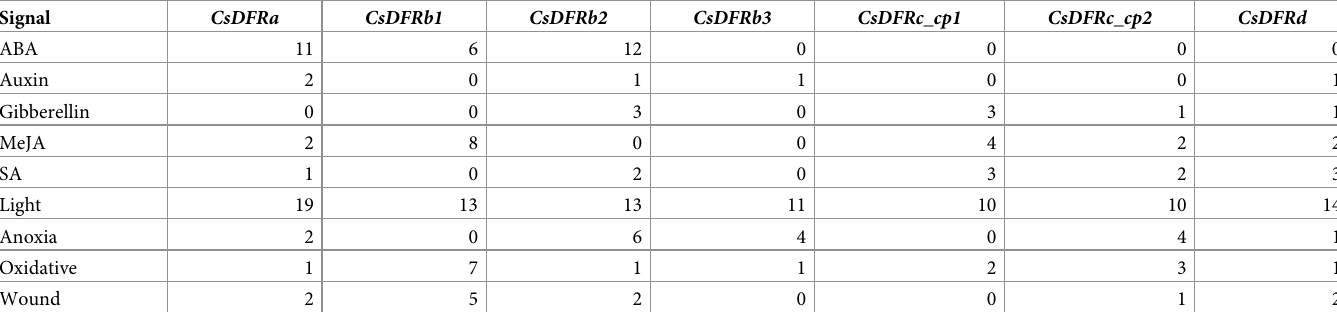
6 exons, and CsDFRa and CsDFRbs have the same intron phases. The gene structures of CsDFRa and CsDFRbs are the same as the DFR from Populus trichocarpa [35]. Analysis of protein sequences and structures of putative CsDFR proteins proved that CsDFRa was the most conserved DFR in tea plant compared to those in other plants. In the protein Blast results, CsDFRb1 is similar to the DFR (Acc. No. PSR99659.1) from Actinidia chinensis var. chinensis, while CsDFRb2 and CsDFRb3 are similar to PSR99661.1. CsDFRc and CsDFRd are similar to PSS16240.1 and PSR99760.1 from Euphorbia pulcherrima . But the function of these DFR in other plants have not yet been identified. The CsDFRa cloned from our Baitang purple tea variety is the same as the CsDFR of Yabukita variety (Acc. No. AB018685.1), and has a two amino acid difference (D159H, V202G) from CsDFR of UPASI- 10 variety (Acc. No. AY648027) in India [18,36], and one difference (E99K) from CsDFR of Line 2043 variety (Acc. No. AY574920) in Sri Lanka [17]. Because only one copy of CsDFRa was detected in genome data, its two types of C-terminal may be not resulted from alternative splicing, but rather due to a mutation. The published CsDFRs in other tea varieties (all cloned from 3’ UTR and sequenced), and the sequence retrieved from CSA genome data are the lon- ger type. The short type is only discovered in CSS genome data and our variety. For that rea- son, our Baitang purple tea might be a hybrid of CSS and CSA.